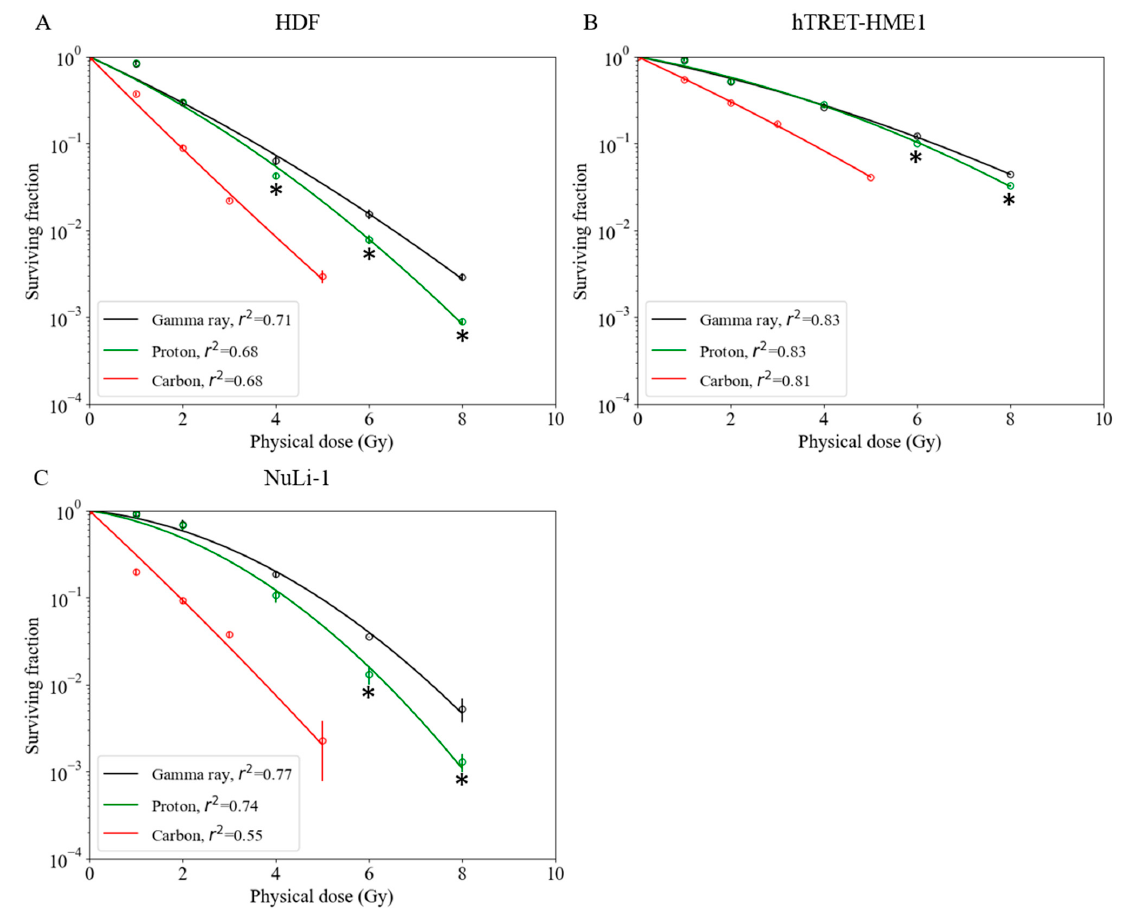
Figure 3. Survival fractions of normal cell lines irradiated with gamma rays, protons, and carbon ions. ( A ) Human dermal fibroblast cell line. ( B ) hTRET-HME1 human mammary epithelial cell line. ( C ) NuLi-1 human bronchial epithelial cell line. Bars indicate confidence intervals of one standard deviation. A minimum of three experiments were performed for each irradiation method. Asterisks indicate significant differences (* p < 0.05; t -test) between survival fractions after irradiation.